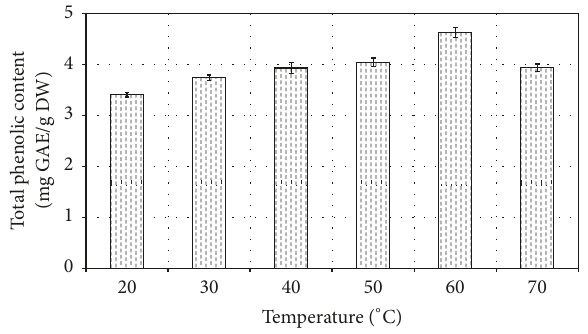
Figure 2: Effect of different temperatures on the extraction output of phenolic compounds from pear fruit